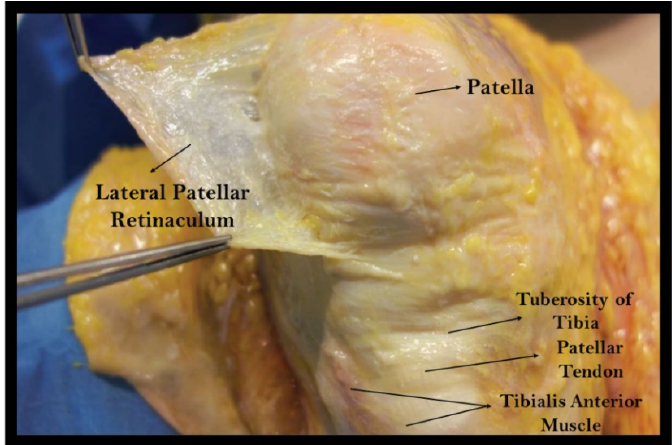
Figure 1. Anatomical study of a right knee, excision of the lateral retinaculum from the antero-lateral aspect of the knee.